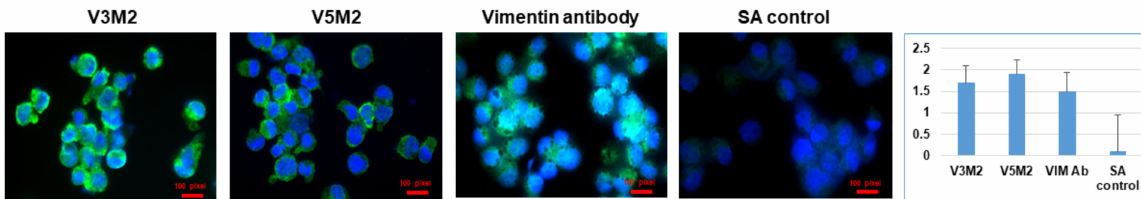
Figure 5. Validating specific binding of selected motifs with the human cell line. Vimentin-expressing IGROV cells were incubated with biotinylated V3M2, V5M2, anti-human vimentin antibody (VIM Ab) or scrambled control (SA) aptamer. Fluorescein isothiocyanate (FITC) conjugated streptavidin was used to detect biotinylated aptamers. The